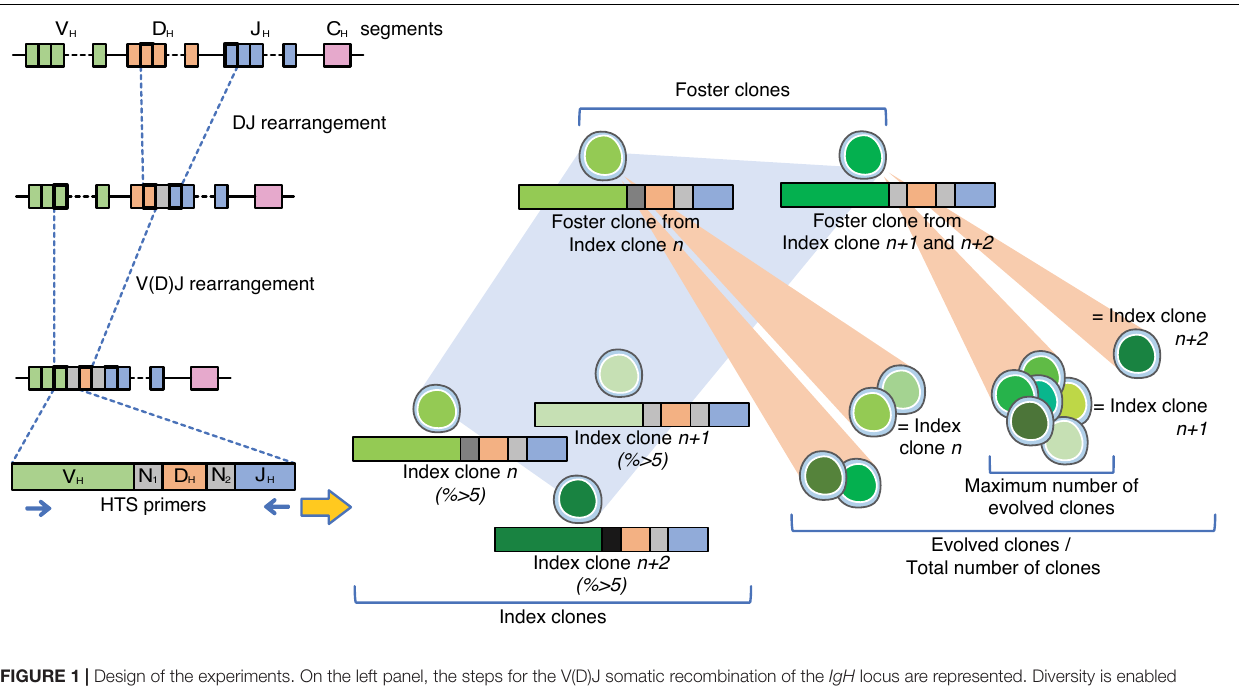
FIGURE 1 | Design of the experiments. On the left panel, the steps for the V(D)J somatic recombination of the IgH locus are represented. Diversity is enabled through a random combination of one of many variables ( V ), diversity ( D ), and joining ( J ) gene segments although the major contributor to the diversity of the immunoglobulin repertoire is the variable truncation of the recombined gene segments in synergy with the addition of non-templated (N) nucleotides, the so-called N regions within the rearrangements (8). Index clones were designated as clones representing ≥ 5% of the individual clonotypes with the same V(D)J rearrangement. Analysis of the V(D)J-sequence allowed identification of related foster clones among index clones. Foster clones were defined as clones with similar D-N 2 -J rearrangements, but other V-rearrangements and N 1 -joining, regardless of their percentage. Evolved clones were clones related to the index and foster clones by sharing the same or partly the same D-J stem, regardless of their frequency. The total number of clones per patient was the sum of evolved clones, and the maximum number of evolved clones was the highest number of evolved clones across all foster